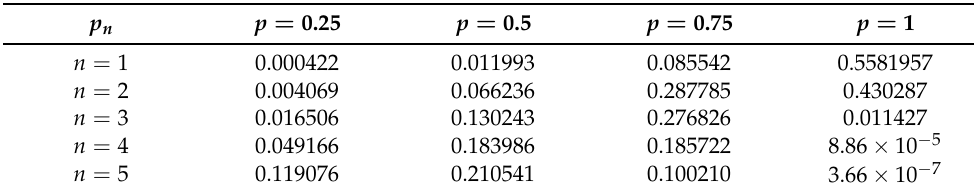
Table 1. Probabilities p n , n = 1, . . . ,5 that arriving SDU joins the queue before the interval x ∈